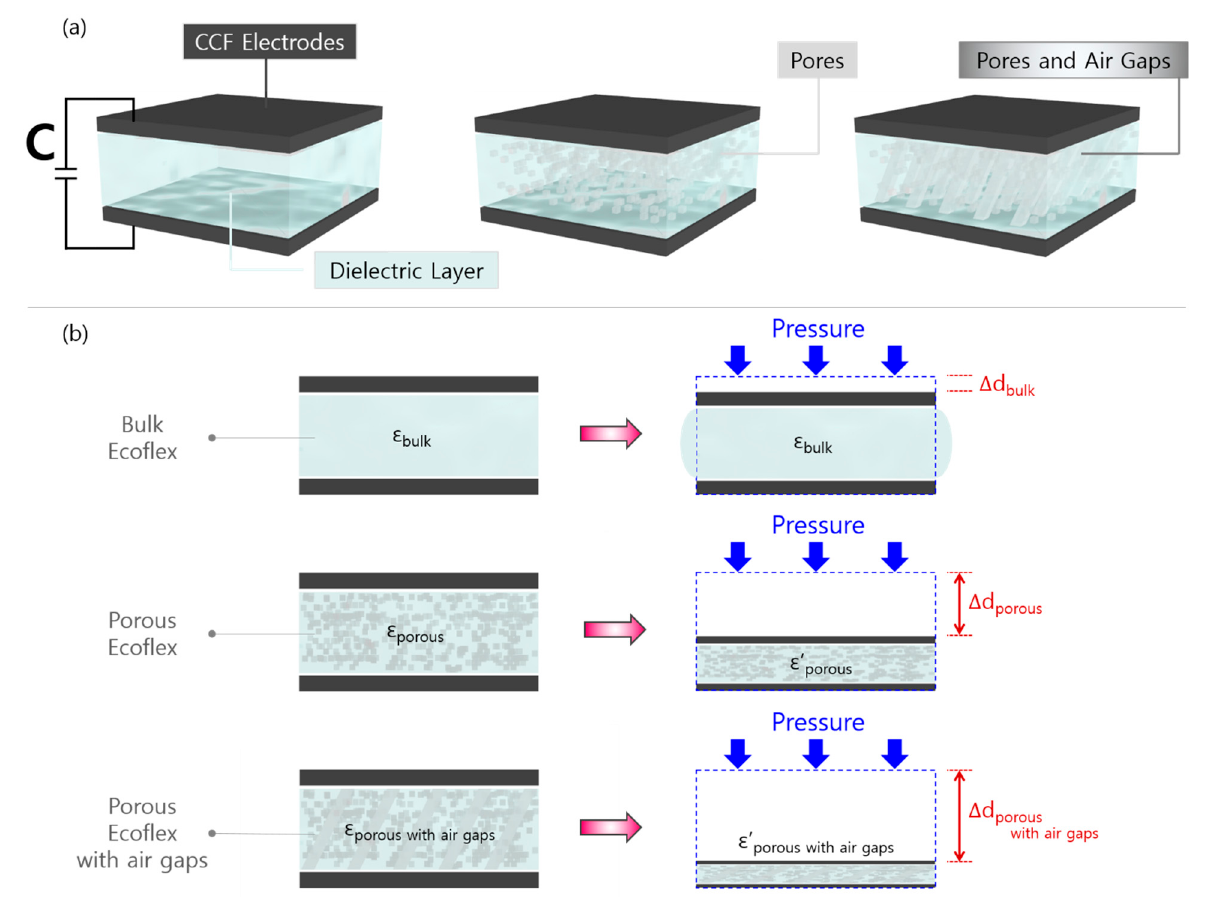
Figure 3. Pressure-sensing mechanisms of capacitive pressure sensors using a bulk Ecoflex, porous Ecoflex, and air gapped-porous Ecoflex. ( a ) Schematic of sensors with three different structures in the dielectric; ( b ) schematic of the structural deformation of capacitive pressure sensors using a bulk, porous, air gapped-porous Ecoflex dielectric layer during compressive loading.